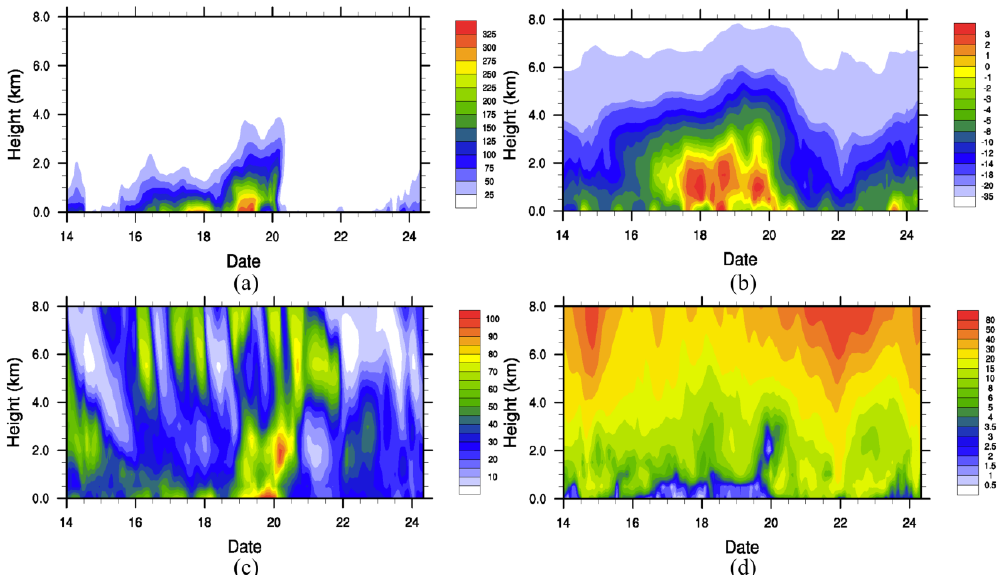
Figure 10. Temporal variations of vertical profiles of simulated (a) PM 2 . 5 (unit: µgm − 3 , b ) temperature (unit: ◦ C, c ) RH (unit: %, d ) wind speeds (unit: ms − 1 ) in Beijing.